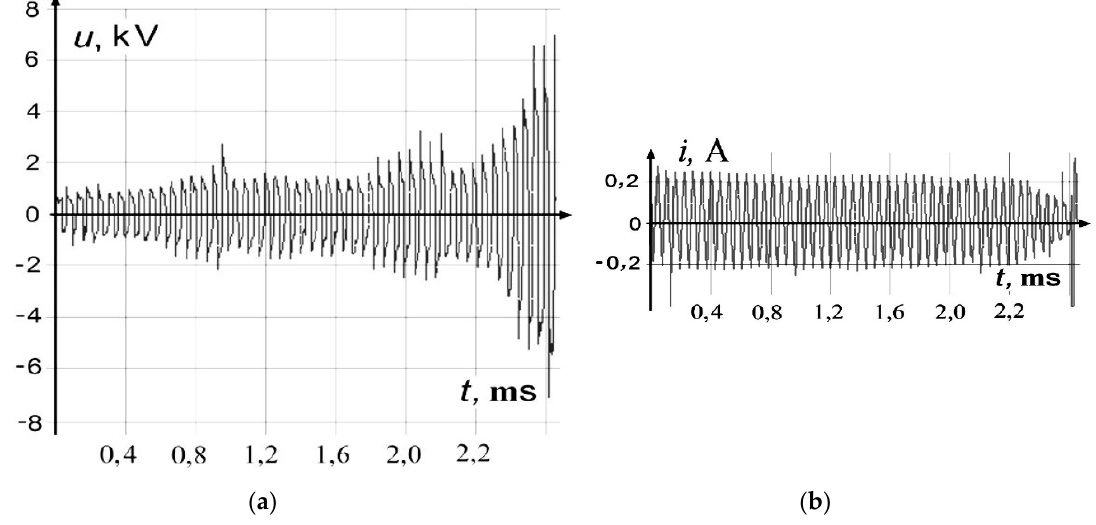
Figure 6. Electrical waveforms in the μ GAD reactor observed during a random plasma cycle under air conditions, voltage ( a ), and current ( b ).